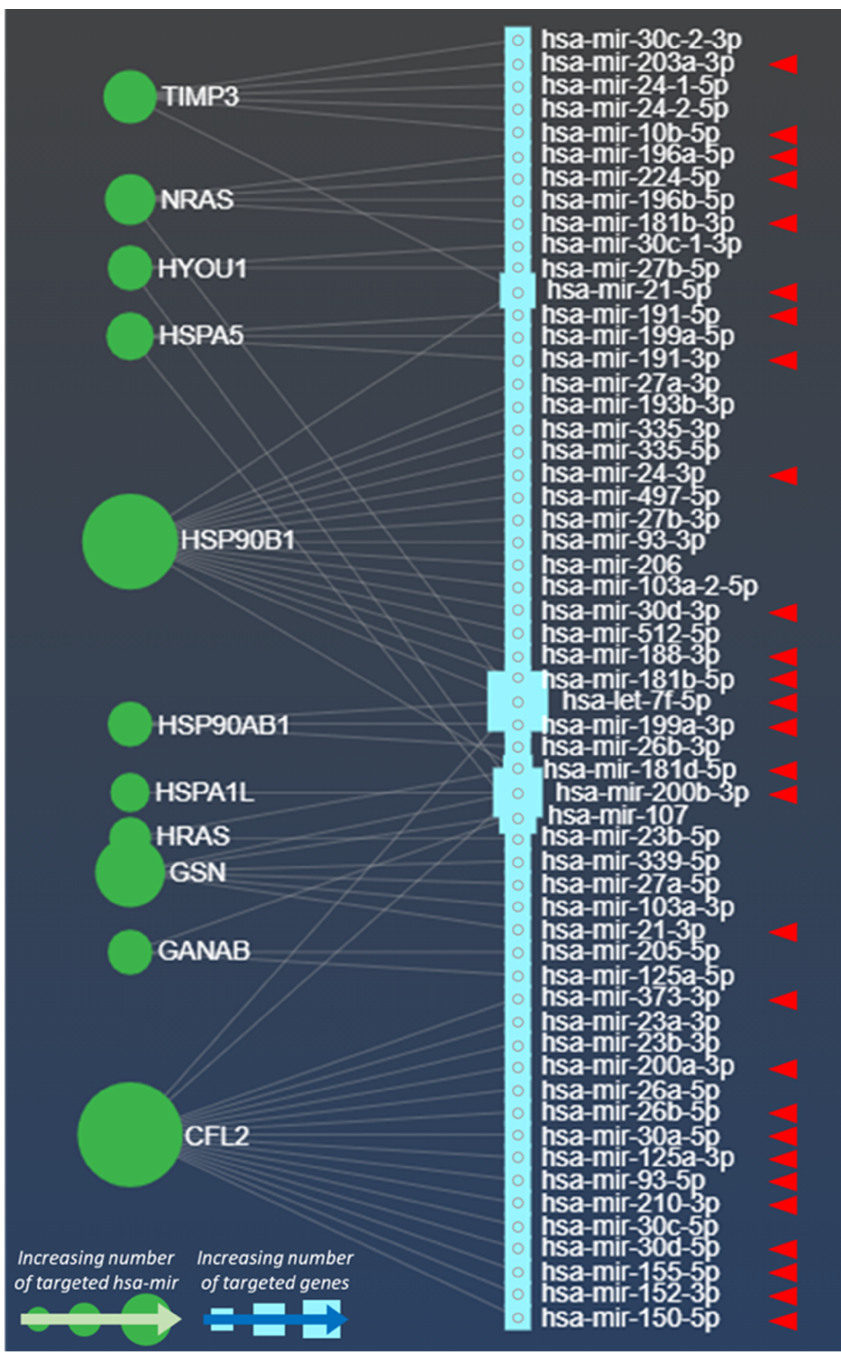
Figure 1. Bipartite network between hypoxic miRNAs and acidic-driven Mexo proteins. These miRNAs are related to hypoxia, and were generally described within Exo, but not within hypoxic Exo. The network (grey lines) displays hypoxia-associated miRNAs (hsa-mir, cyan squares; n = 57) targeting the indicated melanoma metastatic genes (green circles) whose expression was found enriched in acidic Mexo (summarized in Table 1). The red arrowheads depict miRNAs experimentally involved in melanoma progression, metastatic expansion and drug therapy resistance (summarized in Table 2). This bipartite network has been generated by interrogating the publicly available database miRNet (https://www.mirnet.ca, accessed on 30 March 2021; see Data Availability Statement for further details) within the exosome dataset ( n = 1250 hsa-mir) and the indicated